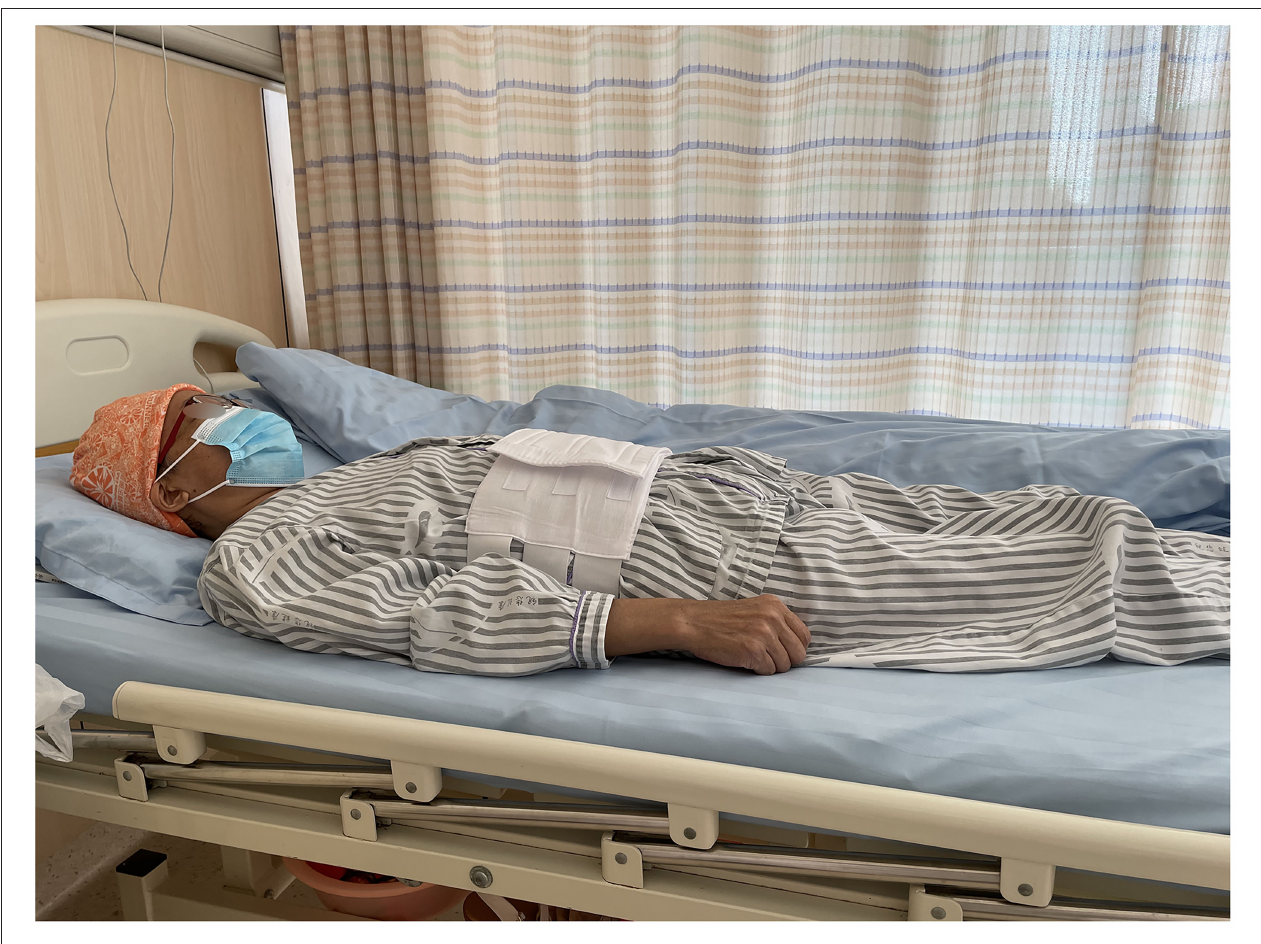
FIGURE 1 | Supine position